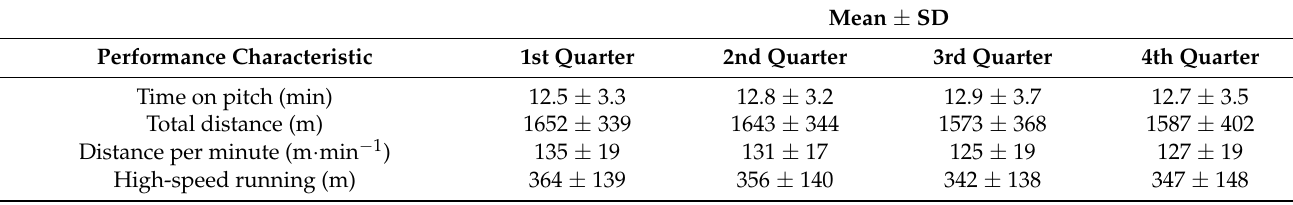
Table 2. Performance characteristics (descriptive data) of male university field hockey players across 2 × 2 × 17.5 min quarters during 70 min national-level matches played in the 2019–2020 season. Global Positioning System (GPS) and heart rate variables are presented as mean ±